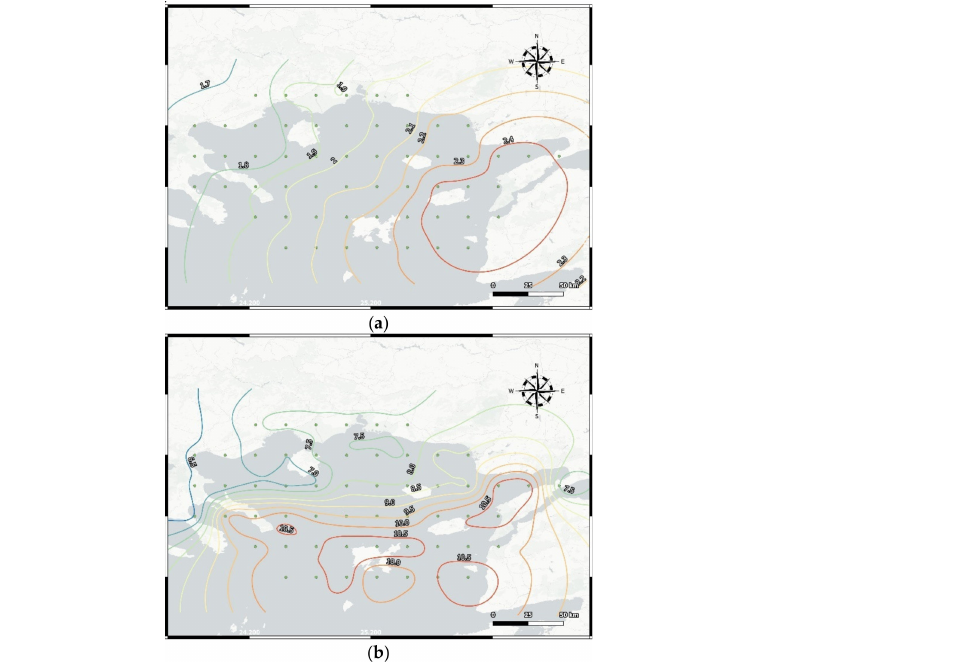
Figure 8. Spatial distribution of the Weibull probability density function parameters: ( a ) the shape parameter k and ( b ) the scale parameter A (in m/s) at the hub level over the study area. Table 3. Total annual wind energy content (in kWh/m 2 ) at hub level, per directional bin, for all sub-areas. Sub-Areas/ Directional